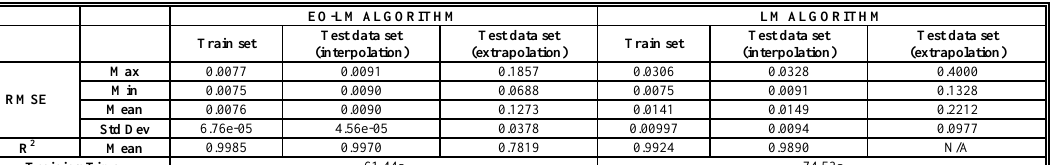
1. In addition to the popular criteria of root mean square error (RMSE) and mean error (ME), the efficiency